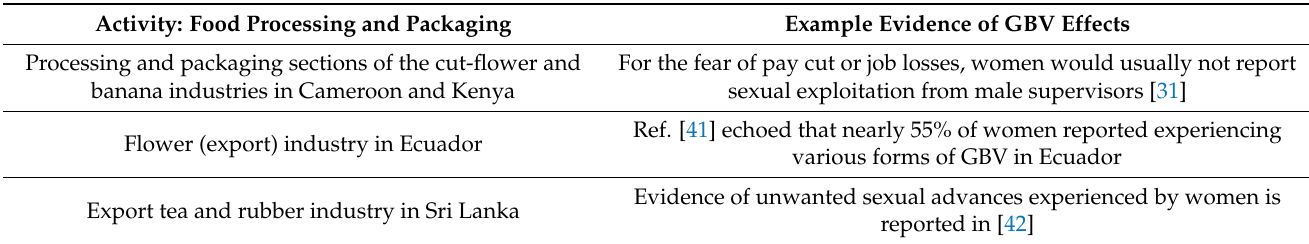
Table 4. Examples of locations where researchers found evidence of GBV effects on food processing and